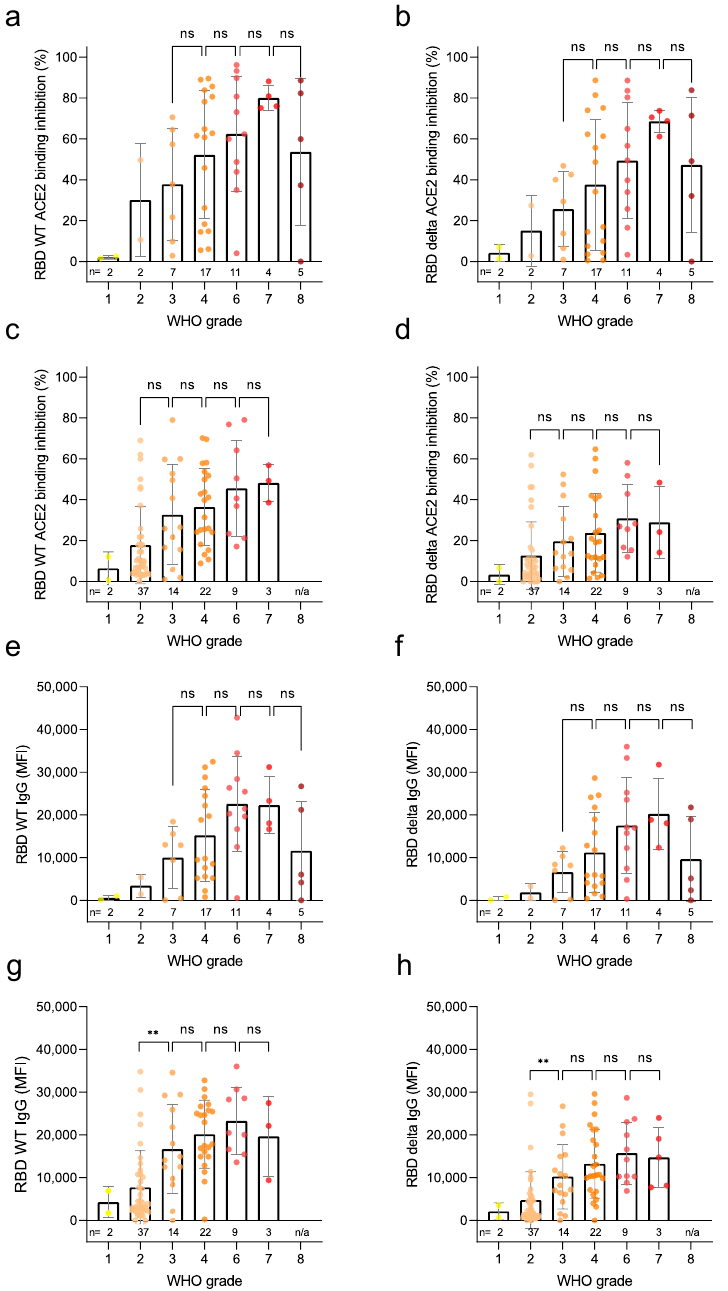
Figure 6. Correlation of anti-RBD IgG levels and ACE2 binding inhibition with SARS-CoV-2 disease severity. Bar charts showing mean ACE2 binding inhibitions (%) against wild-type and delta RBD are correlated with WHO grades for disease severity for samples 7–49 days post PCR ( a , b ) and ≥ 50 days post PCR ( c , d ). Mean anti-RBD WT IgG and anti-RBD delta IgG levels are shown for samples 7–49 days post PCR ( e , f ) and ≥ 50 days post PCR ( g , h ). Individual samples are displayed as colored dots, bars indicate the mean of the dataset with error bars representing standard deviation. Number of samples is given below the columns (n). If no samples for a group were available, the column is labeled with “n/a”. WHO grade 1—ambulatory/no limitations of activities, 2—ambulatory/limitation of activities, 3—hospitalized, mild disease/no oxygen therapy, 4—hospitalized, mild disease/mask or nasal prongs, 6—hospitalized, severe disease/intubation + mechanical ventilation, 7— hospitalized, severe disease/ventilation + additional organ support (pressors, RRT, ECMO), 8—Death. The study did not contain samples of WHO grade